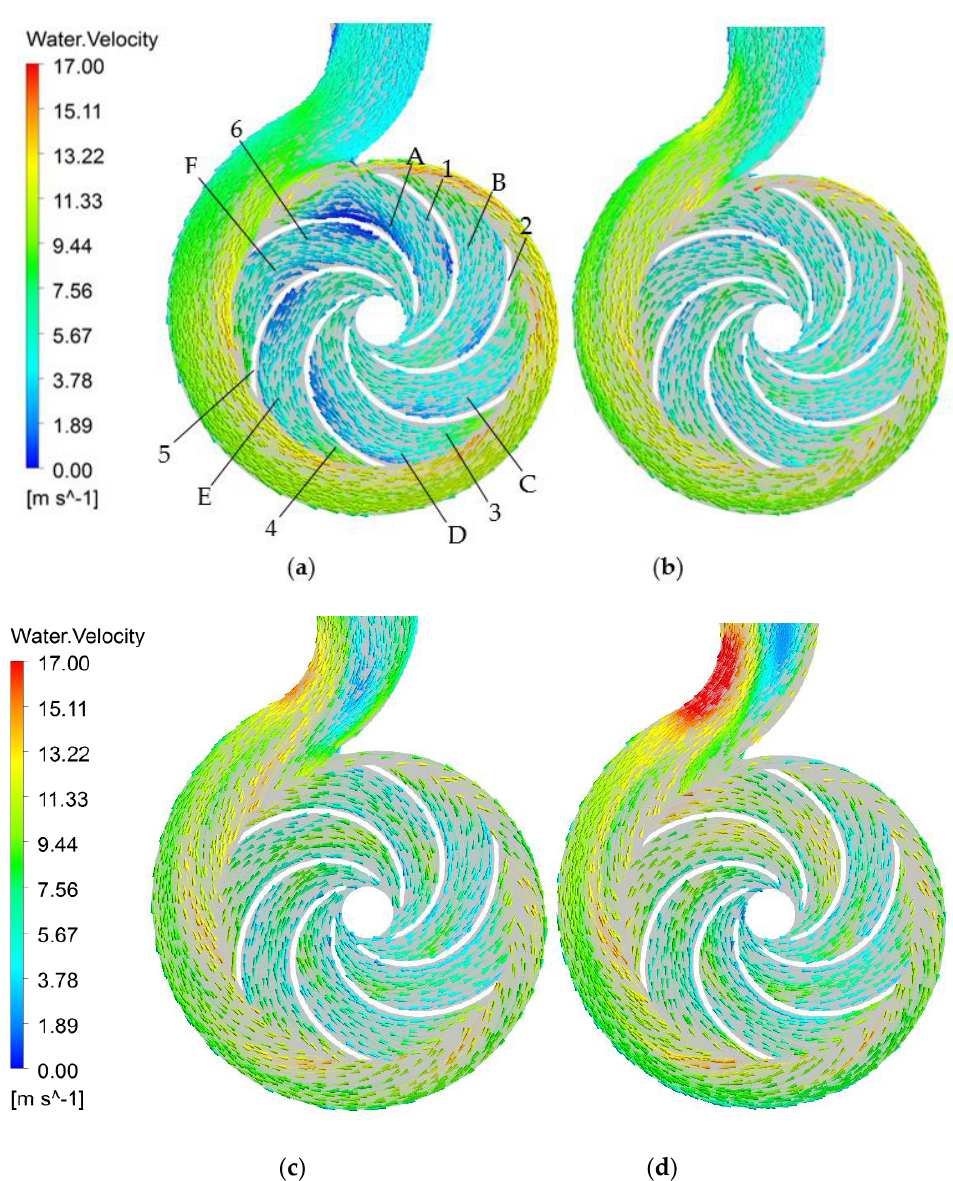
Figure 12. Water velocity distribution in axial plane b at different flow rates. ( a ) 0.6 Q d , ( b ) 0.8 Q d , ( c ) 1.0 Q d , ( d ) 1.2 Q d .